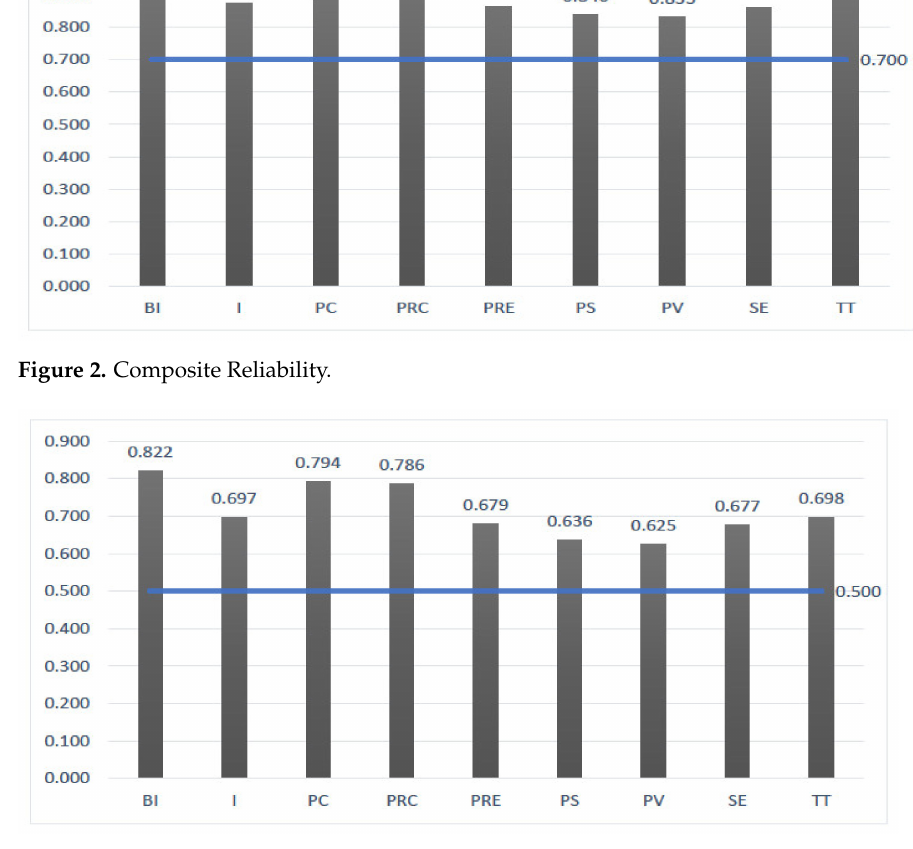
Figure 3. Average Variance Extracted